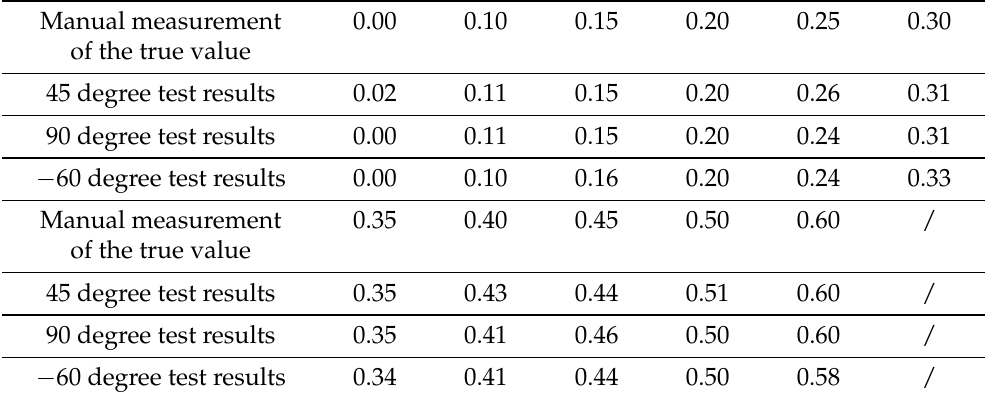
Table 9. Random angle rotation measurement